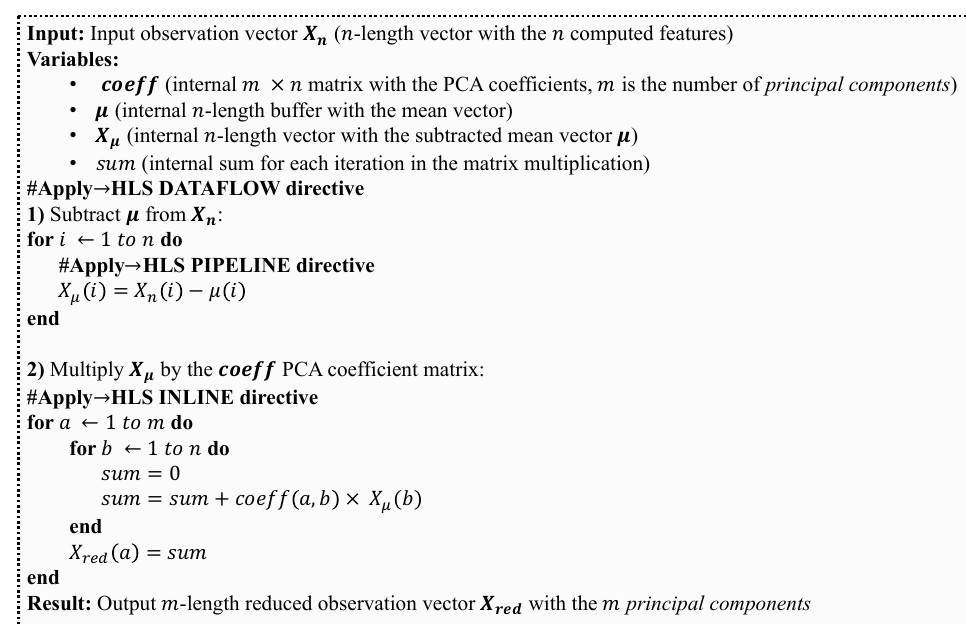
Figure 9. Pseudocode for the HLS principal component analysis (PCA) computing module in Figure